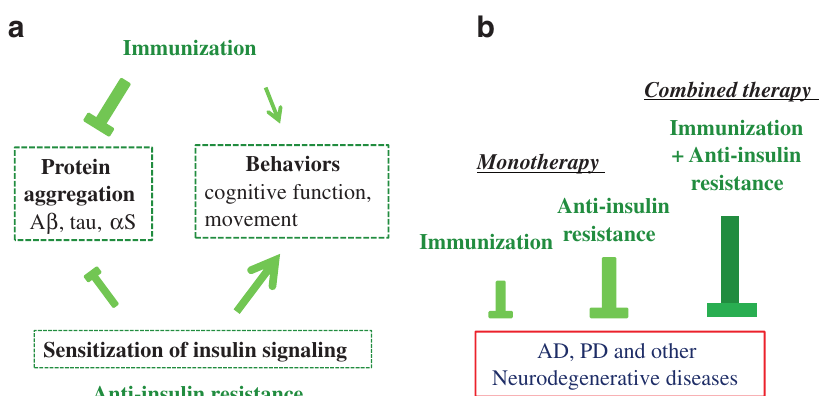
Fig. 5 Schematics of the combined immunotherapy with “ anti-insulin resistance ” . a A schematic fi gure showing that immunization is ef fi cient to suppress aggregation of amyloidogenic proteins, but not to improve behaviors, including cognitive function and movement. On the other hand, “ anti-insulin resistance ” therapy is bene fi cial for both protein aggregation and behaviors. b Combined immunotherapy with “ anti-insulin resistance ” therapy may be ef fi cient compared to each